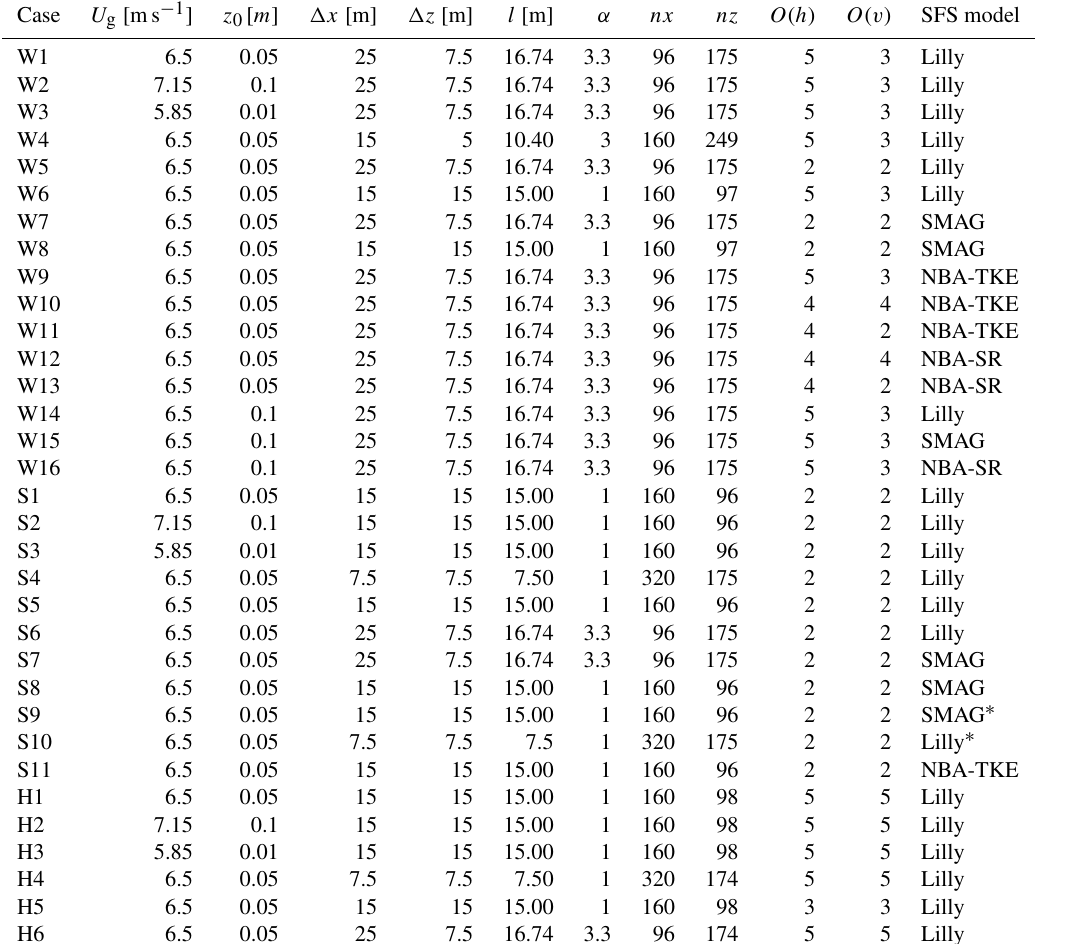
Table 1. Forcing and configuration parameters for the neutral-case sensitivity studies, using WRF (W), SOWFA (S), and HiGrad (H), as described in the